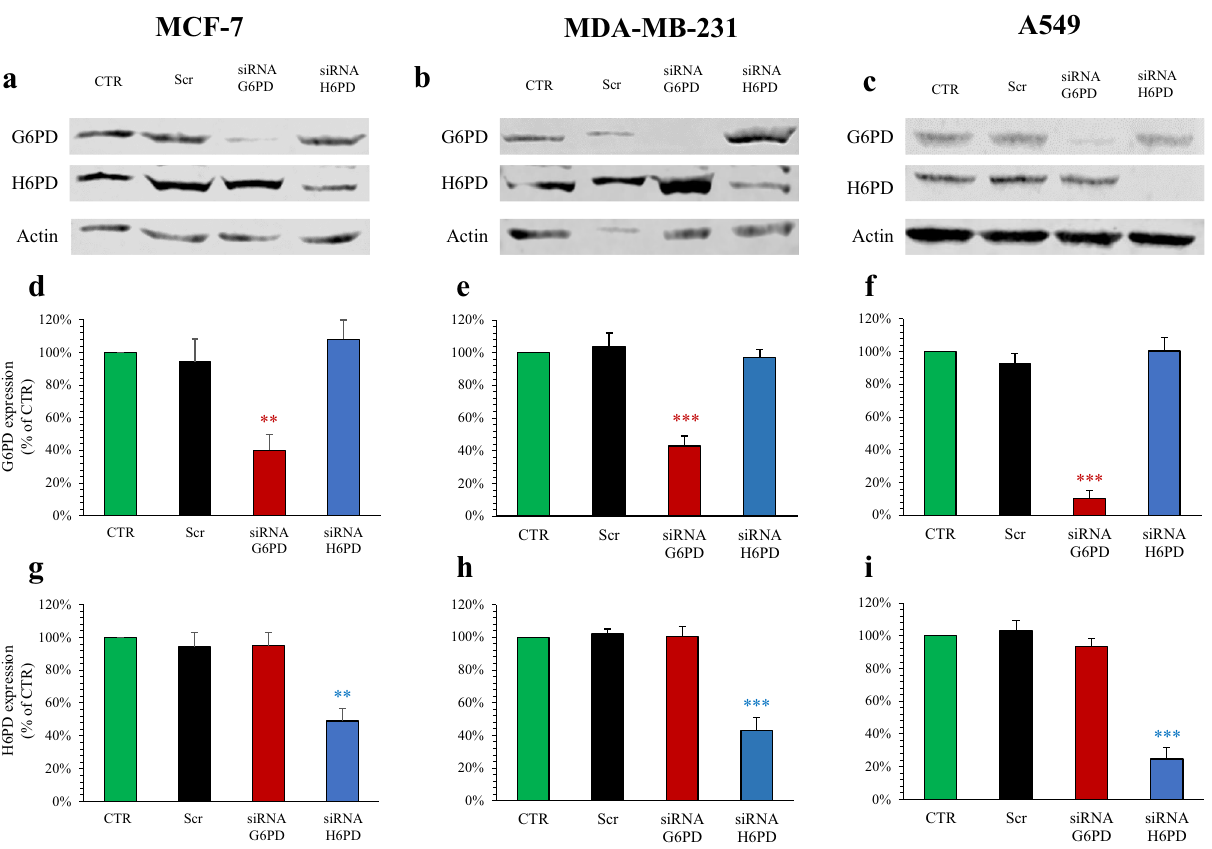
Figure 1. G6PD and H6PD Gene Expression after siRNA transfection. Representative images of western blot analysis of MCF-7 ( a ), MDA-MB-231 ( b ) and A549 ( c ) (run under the same experimental conditions for each cell line), reporting G6PD, H6PD and Actin expression. Relative densitometry analyses of G6PD and H6PD expression in MCF-7 ( d , g ), MDA-MB-231 ( e , h ) and A549 ( f , i ), under control condition (CTR, green), scramble siRNA (Scr, black), siRNA G6PD (red) and siRNA H6PD (blue). In all cell lines, scramble siRNA-transfected cells did not show significant variations in the levels of G6PD and H6PD with respect to control ones. G6PD siRNA delivery significantly reduced G6PD expression in MCF-7 ( d ), MDA-MB-231 ( e ) and A549 ( f ), while keeping unaltered H6PD expression. Similarly, H6PD siRNA transfection selectively reduced enzyme expression in MCF-7 ( g ), MDA-MB-231 ( h ) and A549 ( i ). Western blot analysis confirmed the efficiency and selectivity of gene silencing in all cancer cell models, documenting the absence of any interference between the trigger enzymes G6PD and H6PD. Data are expressed as % ± SD of respective control condition (n = 3). **p < 0.01, ***p < 0.001 vs corresponding scramble. The full-length gels are presented in Supplementary Fig.